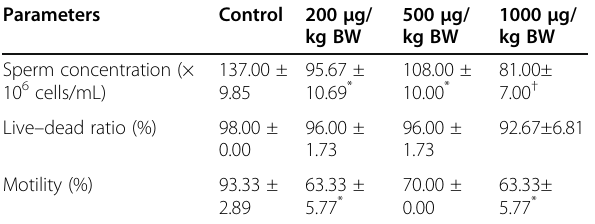
Table 3 Effect of ethyl acetate fraction of Waltheria indica Linn . root on sperm parameters of male Wistar rats (Mean ± SD, n